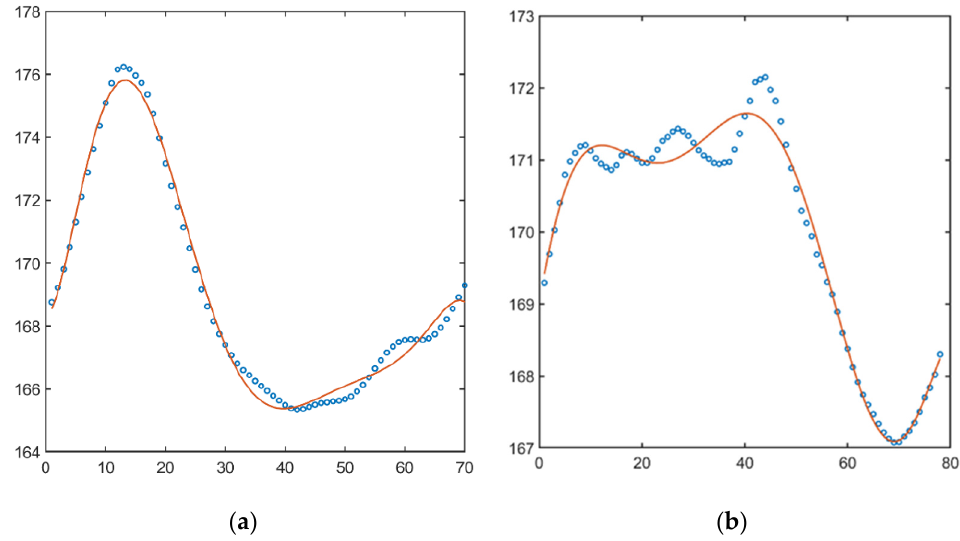
Figure 3. Change in the hip angle in swing phase ( a ), stance phase ( b ).